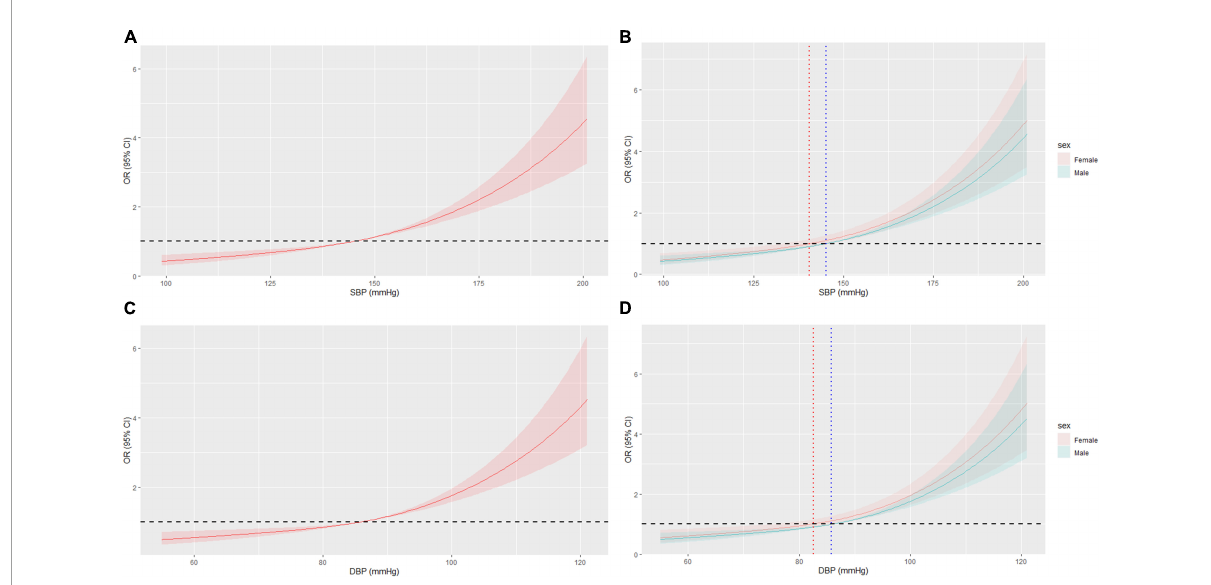
FIGURE5 Restricted cubic spline (RCS) of BP and AF in HBP patients after PSM. (A) RCS of SBP and AF. (B) RCS of SBP and AF in different sex, OR = 1 when SBP = 140.5 mmHg or 145.1 mmHg in female or male, respectively. (C) RCS of DBP and AF. (D) RCS of DBP and AF in different sex, OR = 1 when DBP = 82.5 mmHg or 85.8 mmHg in female or male, respectively. AF, atrial fibrillation; BP, blood pressure; HBP, hypertension; OR, odd ratio; PSM, propensity score matching.